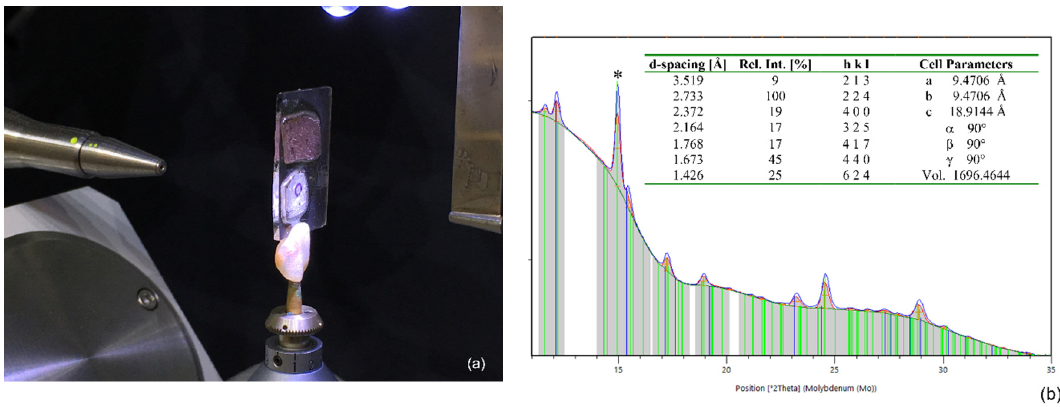
Figure 4. ( a ) Instrumental configuration of micro ‐ XRD measurements, carried out directly on a polished thin ‐ section, where two tesserae (one purple on the top—PD ‐ PR1, and one light brown/amber on the bottom—PD ‐ NC1) were mounted; note that the sample analysed is located within the black circle visible on the light brown/amber tessera; ( b ) micro ‐ XRD pattern of tessera PD ‐ NC1. In the table inset, list of peaks (showing d ‐ spacing, relative intensity and hkl indices) and cell parameters of manganese ‐ containing inclusion. Note that the peak identified by *, having d hkl equal to 3.36 Å, is assigned to cassiterite (the main opacifier of NC tesserae from Padova, and it is not considered in the present paper).